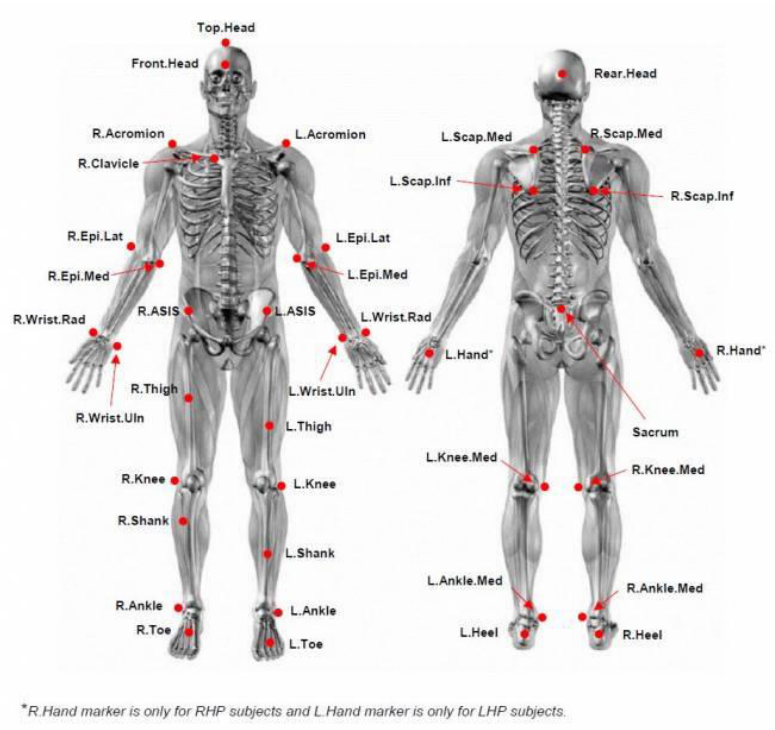
Appl. Sci. 2021 , 11 , 225